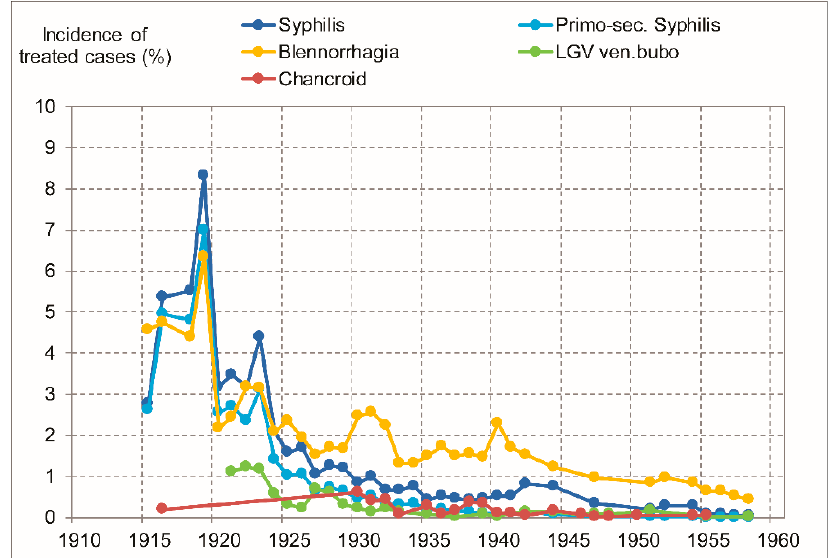
Figure 2. Incidence of treated cases (in %) of several STD conditions in European adults of the province that included Leopoldville (only males for chancroid and LGV venereal bubo). Chancroid data was published regularly only after 1930, and, before that, only once, in 1916. For details, see main text. The data supporting this figure are presented in Supplementary Dataset S1.